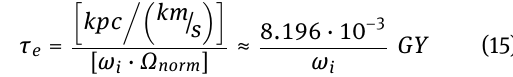
Figure 11. Calculated eigenvalues of the main (in increments) unsta- ble branches of the m = 2 harmonic, depending on the parameter R σ , at fixed value of parameter M * = 15. The model gas disk has the velocity profile (7), (8) with parameters (10), and α The unperturbed surface density σ 0 ( r ) is described by (13), (14). Notation – as in Figure 7. The asterisks show the eigenvalues for the case σ 0 = const . Top panel – phase angular velocity of waves ω r / m , bottom panel – increment ω i